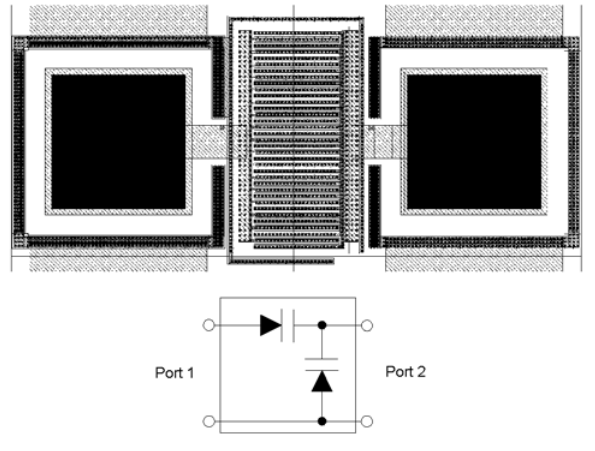
FIGURE 12 Floating varactor design